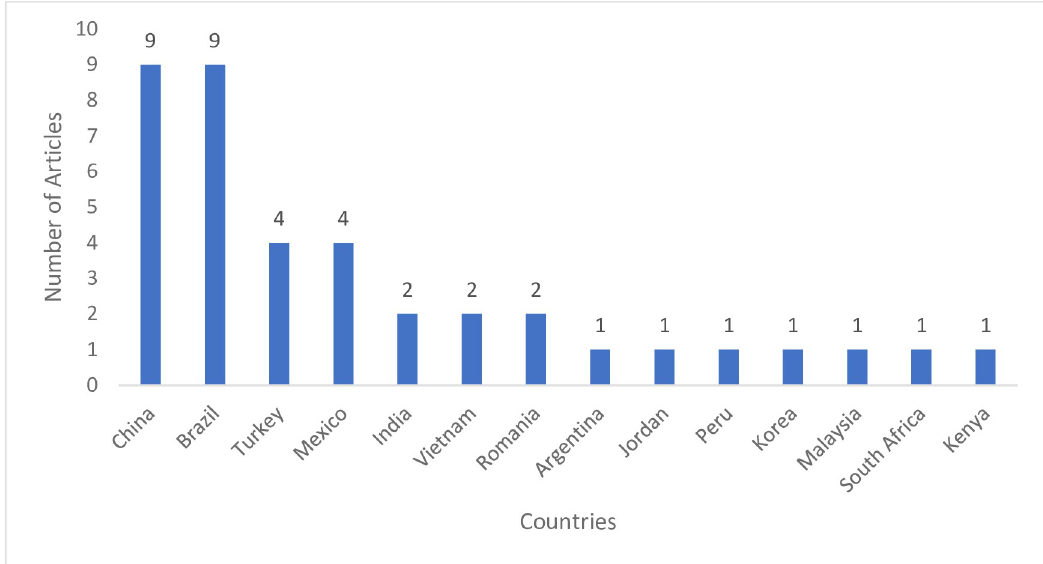
Fig 3. Bar chart showing the distribution of articles per